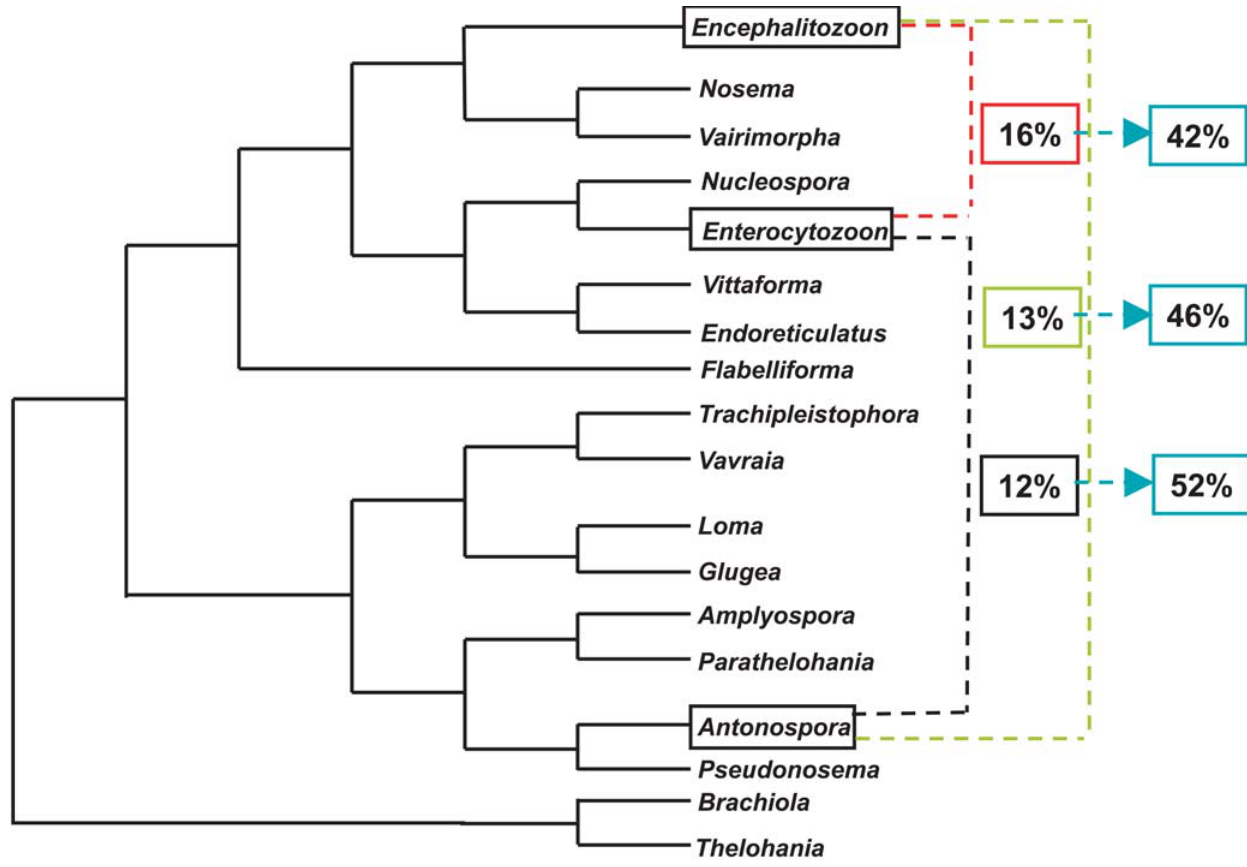
Figure 5. Schematic representation of phylogenetic relationships among microsporidian genera based on SSU rDNA sequences using Maximum Likelihood and genetic distances (Neighbor-Joining) [ 20,30. ] Colored boxes linking pairs of taxa indicate the percentage of conservation of adjacent pairs of genes. Blue boxes indicate the percentage of adjacent loci that are also adjacent in the third microsporidian species analysed in this study.